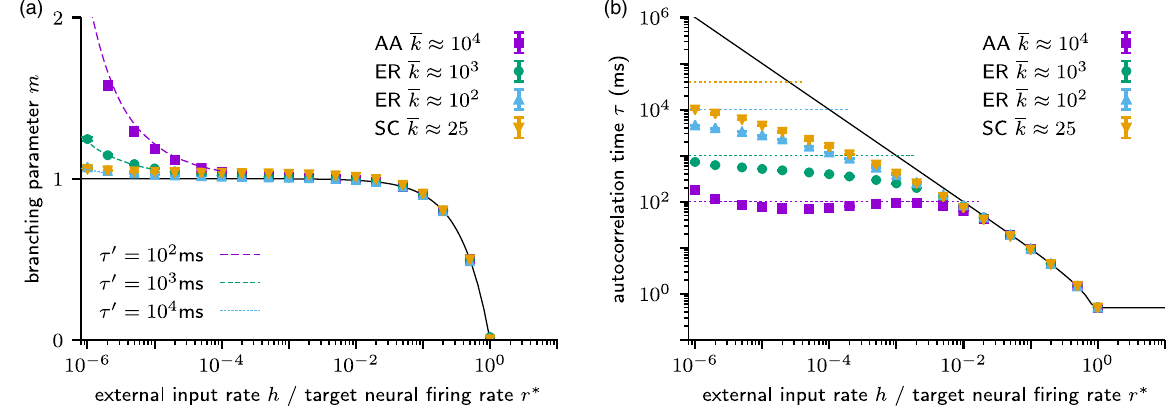
FIG. 4. Quantitative distinction between dynamic states induced in neural networks of different topologies by homeostatic plasticity as 10 3 s, r (cid:2) ¼ 1 Hz, a function of normalized input rate h=r (cid:2) . Data points are averages over 12 independent simulations ( N ¼ 10 4 , τ hp ¼ Δ t ¼ 10 − 3 s) with connections generated according to AA, ER, or SC topologies with average number of connections ¯ k . Solid lines show the mean-field solution in Eq. (7); dashed lines represent (semianalytical) approximations of the bursting regime. (a) Branching parameter m ¼ h m i varies from irregular ( m ≈ 0 ), to fluctuating ( m ⪅ 1 ), to bursting ( m > 1 ) dynamics. The behavior in the bursting = ¯ k . (b) Integrated autocorrelation time of the network population activity regime strongly depends on the network timescale τ 0 ¼ τ hp (Appendix B-3) shows a crossover from irregular [ τ ¼ O ð Δ t Þ ], over fluctuating [ τ ¼ − Δ t= ln ð 1 − h=r (cid:2) Þ ] to bursting ( τ ≈ τ 0 )